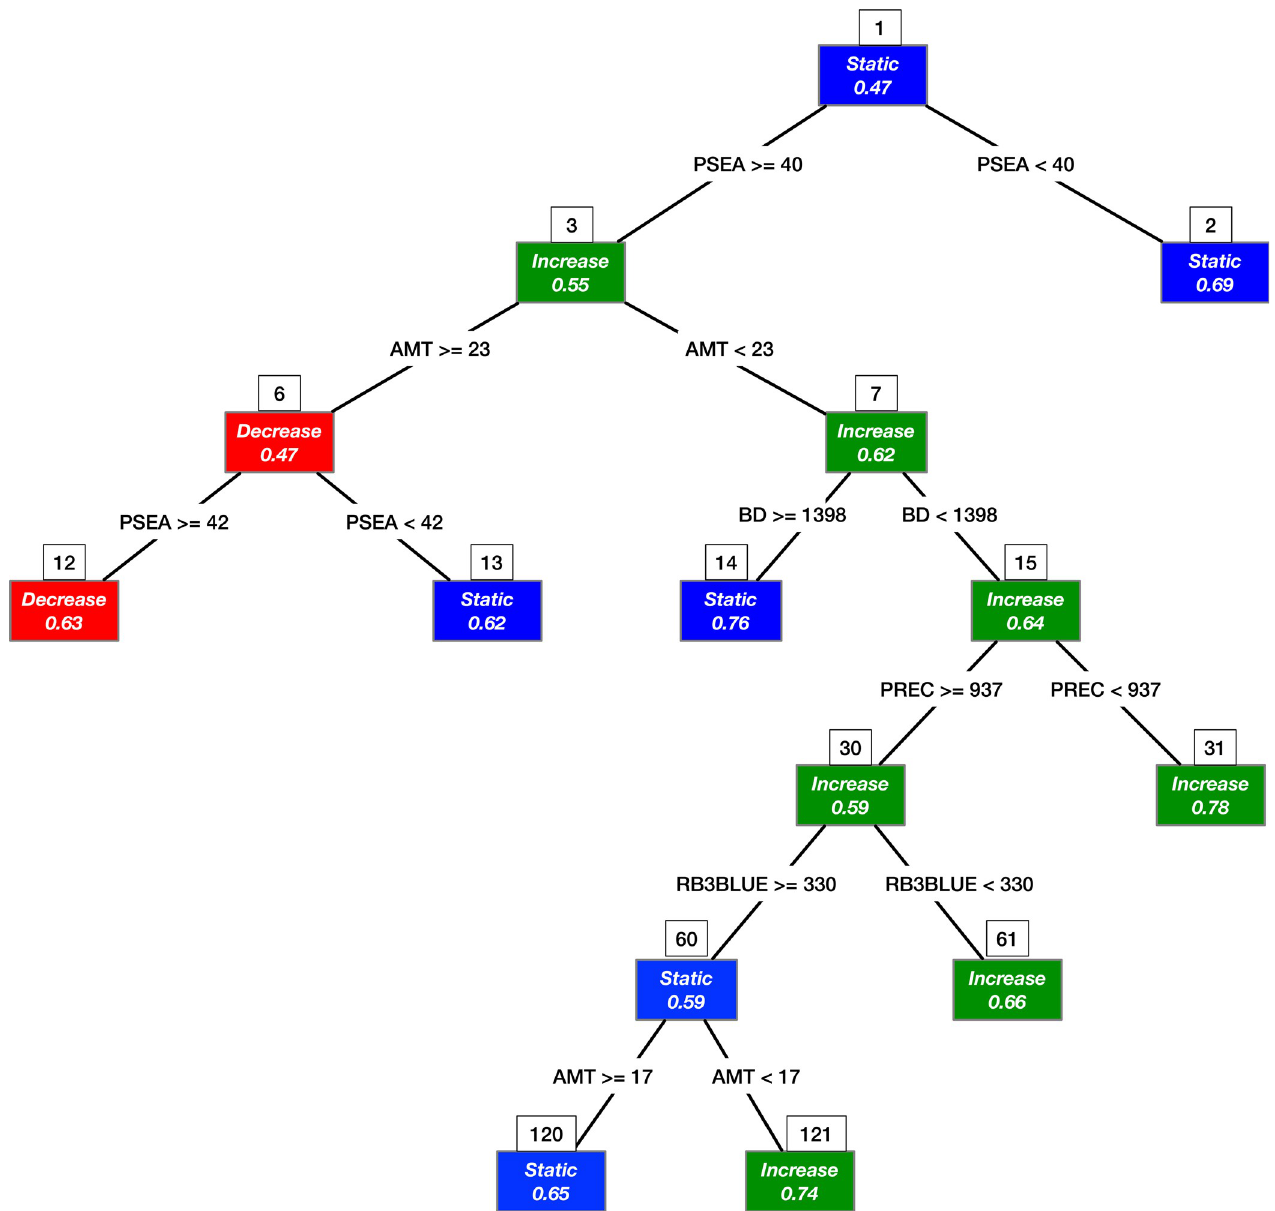
Fig 11. Classification and regression tree (CART) showing the biophysical factors associated with geographic shift in banana at national level. Probabilities for each geographic shift class are included within the coloured boxes. The node number at which a split occurs are shown above the coloured